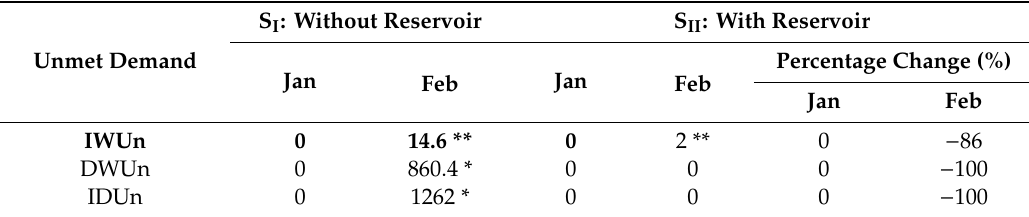
Table 8. The change in monthly unmet demand by each purpose in S I and S II .